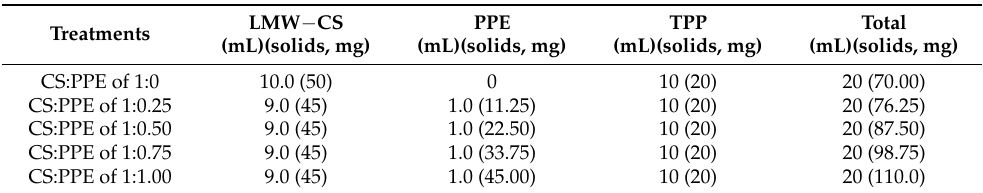
Table 1. Different formulations (treatments) to prepare chitosan nanoparticles (CSNPs) incorporating pomegranate peel extract